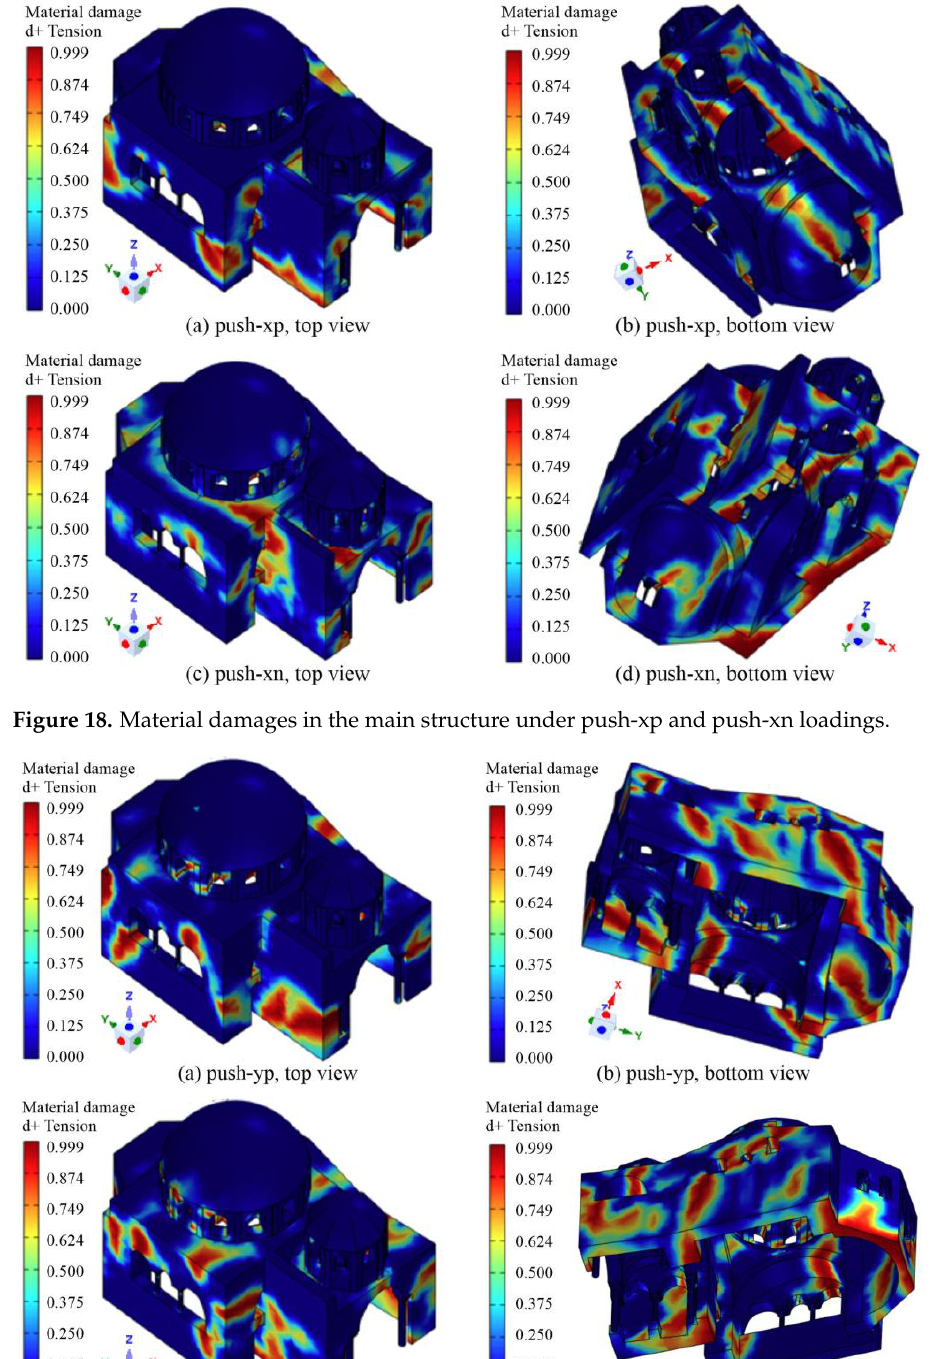
Figure 17. Displacement contour of the main structure at ultimate strength under lateral loads.